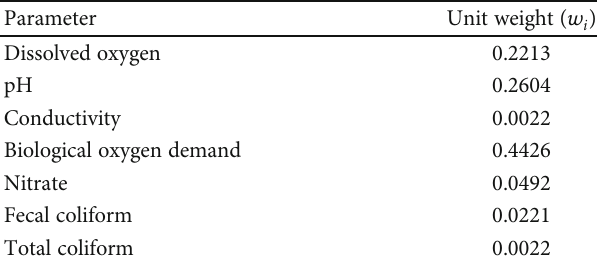
Table 2: Parameter unit weights.